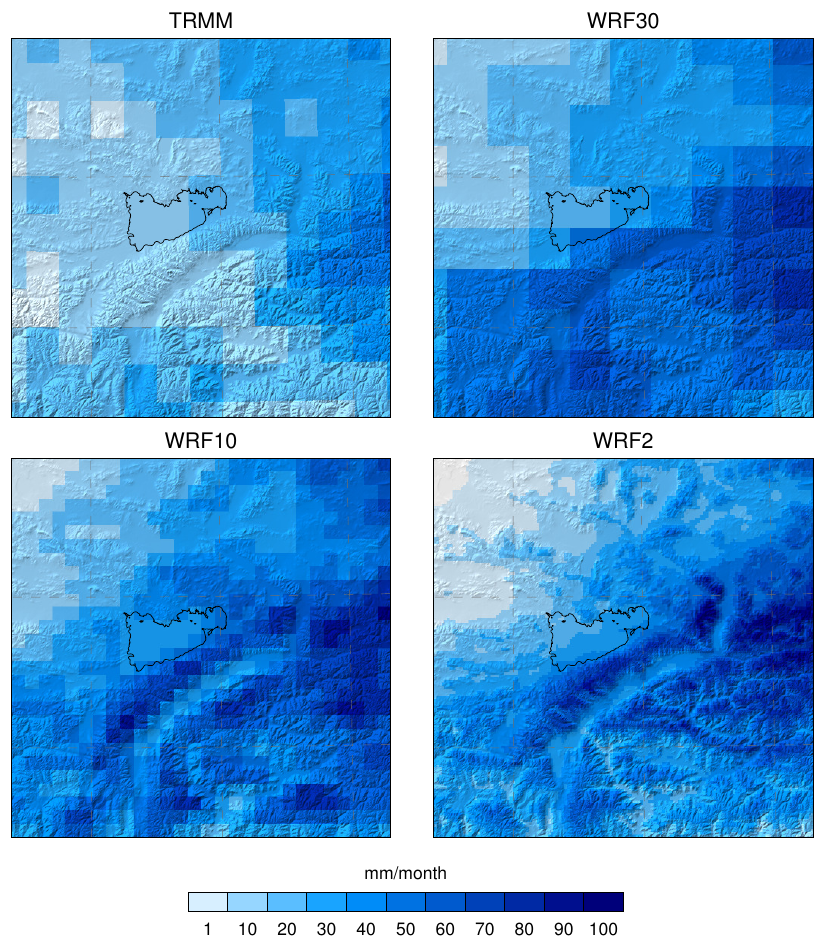
Fig. 12. Spatial distributions of precipitation amounts in October 2008 observed by TRMM and predicted by the one-month WRF30, WRF10 and WRF2 simulations on the SD.